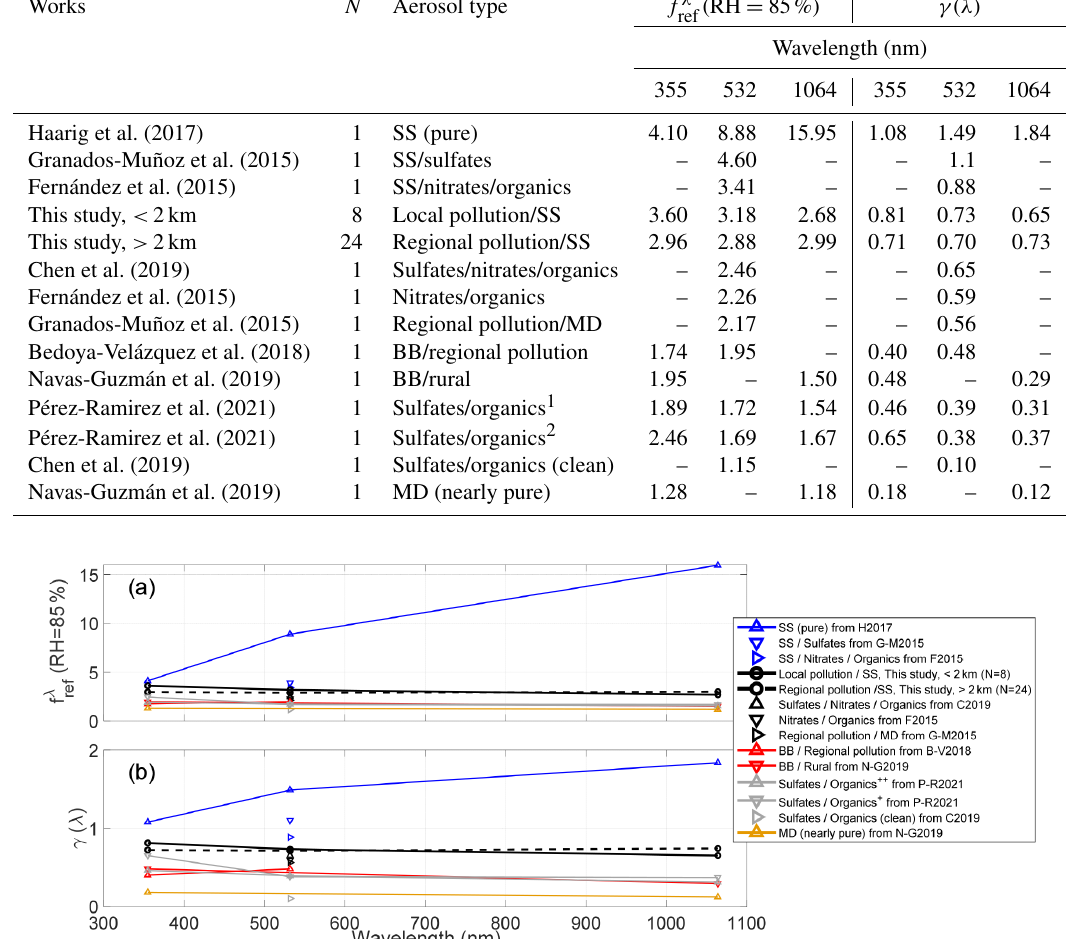
at RH = 85% and RH ref = 40% and (b) γ ( λ ) from the literature and from this study as a function of wavelength. Colored Figure 6. (a) f λ ref symbols represent the dominating regime: blue for sea salt, black for pollution, red for biomass burning, grey for traffic + rural and clean, and orange for mineral dust. The references are Haarig et al. (2017) (H2017), Granados-Muñoz et al. (2015) (M-G2015), Fernández et al. (2015) (F2015), Chen et al. (2019) (C2019), Bedoya-Velásquez et al. (2018) (B-V2018), Navas-Guzmán et al. (2019) (N-G2019) and Pérez-Ramírez et al. (2021) (P-R2021). Organics ++ indicates a greater amount of organics compared to Organics +